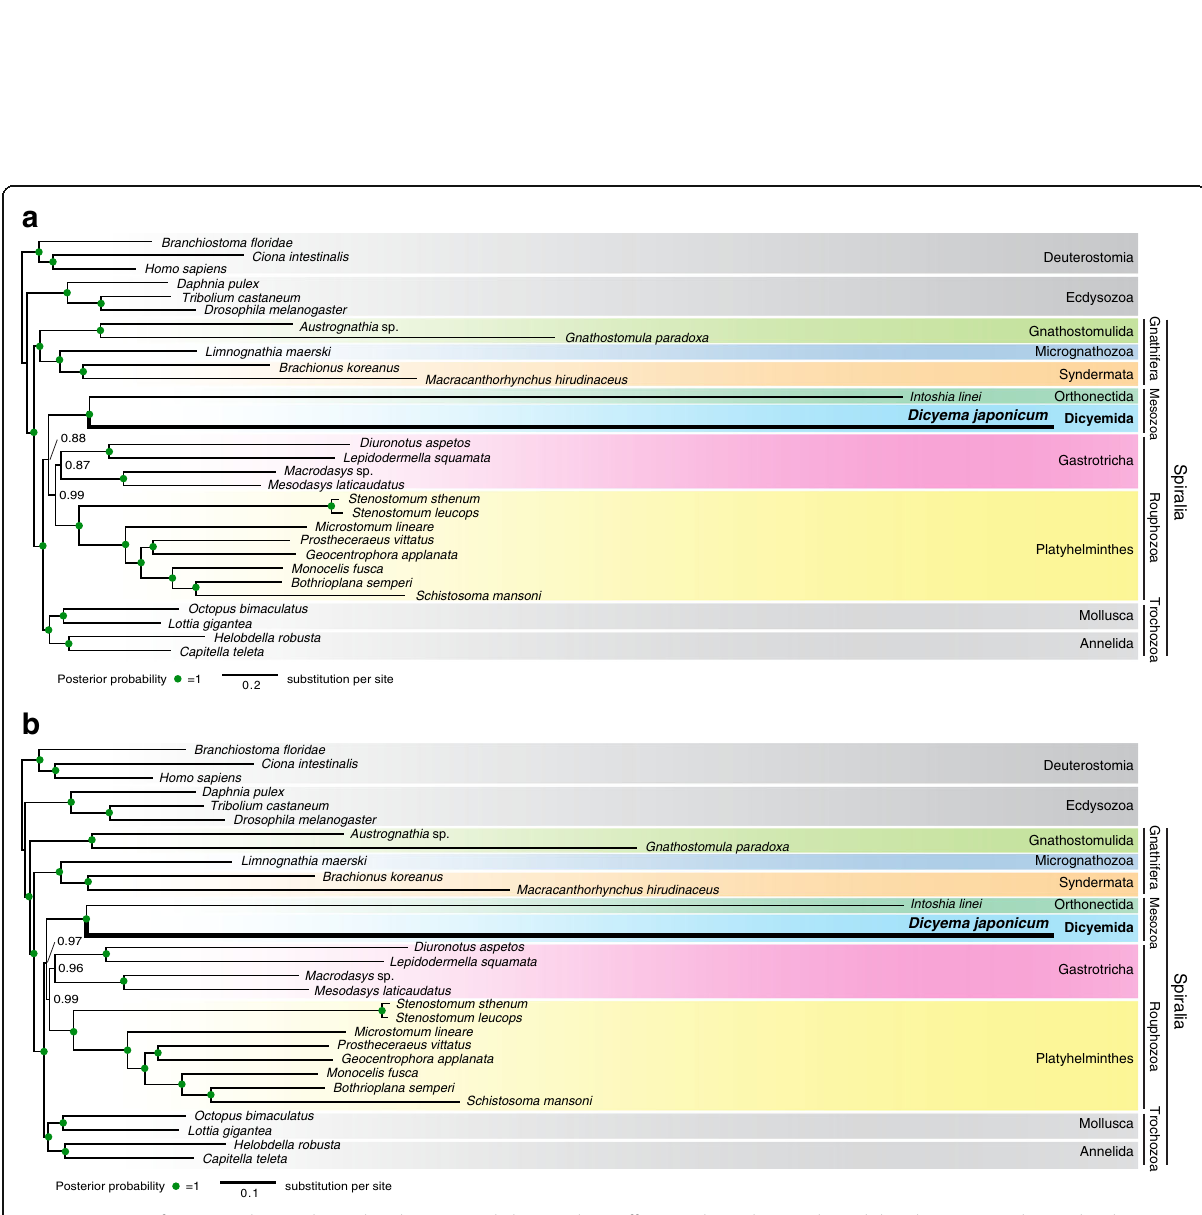
Fig. 4 Bayesian inference analyses indicate that the Dicyemida have a closer affinity to the Orthonectida, and that the Mesozoa diverged early as a sister group to the Rouphozoa. Bayesian inference analysis was performed on three datasets, and each dataset ran three independent trains under the CAT+GTR model using PhyloBayes-MPI. Convergence of three chains occurred with a maxdiff value of <0.15. The trees inferred from Dataset 1 ( a ) and Dataset 2 ( b ) show that the Dicyemida and Orthonectida comprise a monophyletic group, sister to the Rouphozoa. Filled green circles indicate a posterior probability of